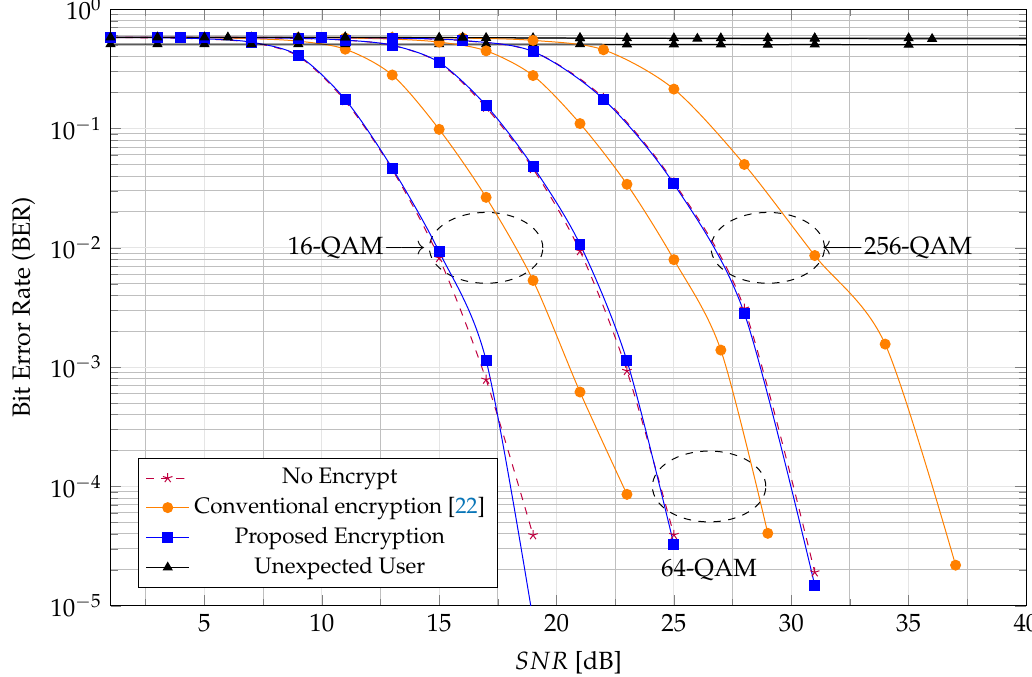
Figure 8. BER performance of 802.11ah with 16-QAM, 64-QAM, and 256-QAM using AWGN